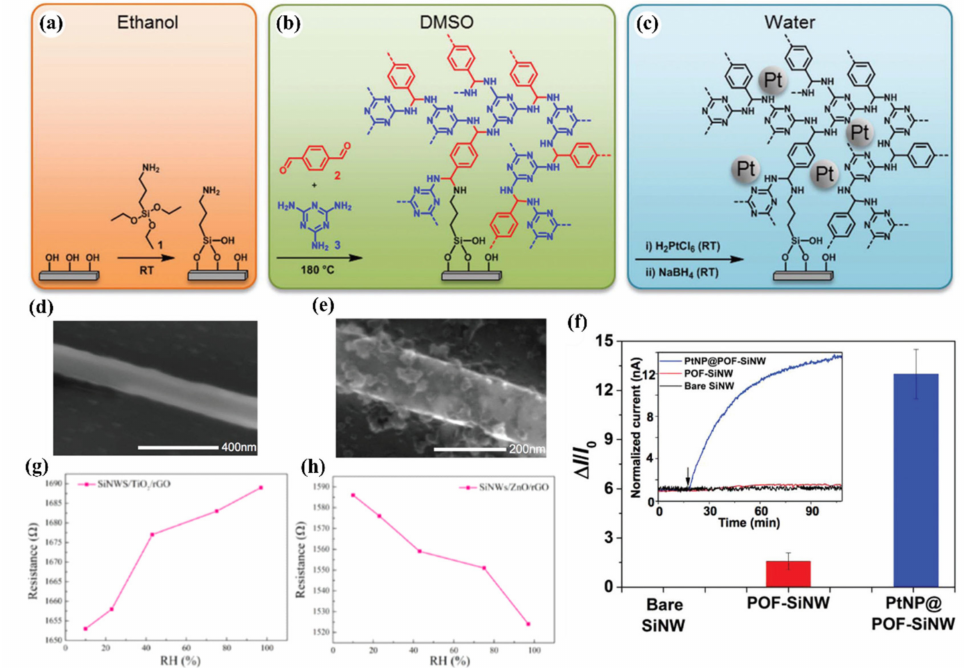
Figure 35. Schematic representation of ( a ) 3-aminopropyltrimethoxysilane grafting to the silanol-terminated surface of a SiNW, ( b ) the covalent modification process of the SiNW surface with melamine-terephthaldehyde-based POFs, ( c ) the metalation of a POF-SiNW via an in situ chemical reduction. Molecules 1–3: APTES, melamine, terephthaldehyde, respectively. SEM images of ( d ) bare SiNW, and ( e ) SiNW decorated with POFs, ( f ) normalized response upon exposure to 3000 ppm of methanol vapor for bare SiNW, POF-SiNW and PtNP@POF-SiNW sensors, and both ( g ) and ( h ) show the resistance of the ZnONPs-SiNW / rGO and TiO 2 NPs-SiNW / rGO as a function of humidity. Reproduced from [15]; and Reproduced from [178], with permission from RSC Pub,